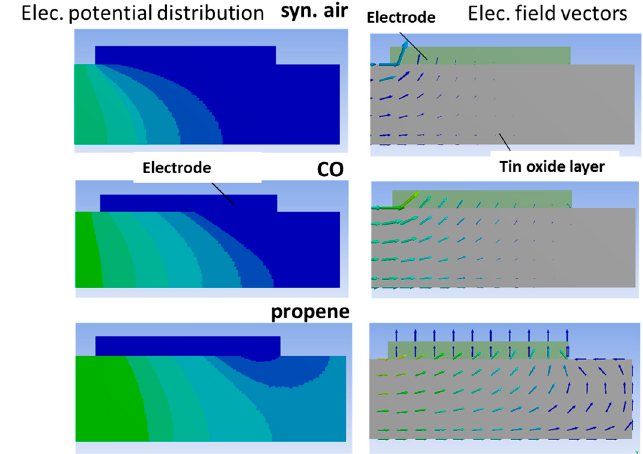
Figure 4. ANSYS Simulation of the electrical potential distribution ( left ) and electric field vectors ( right ) in an electrical model of a tin oxide layer under a platinum terminal electrode in synthetic air ( top ), CO ( middle ) and propene ( bottom